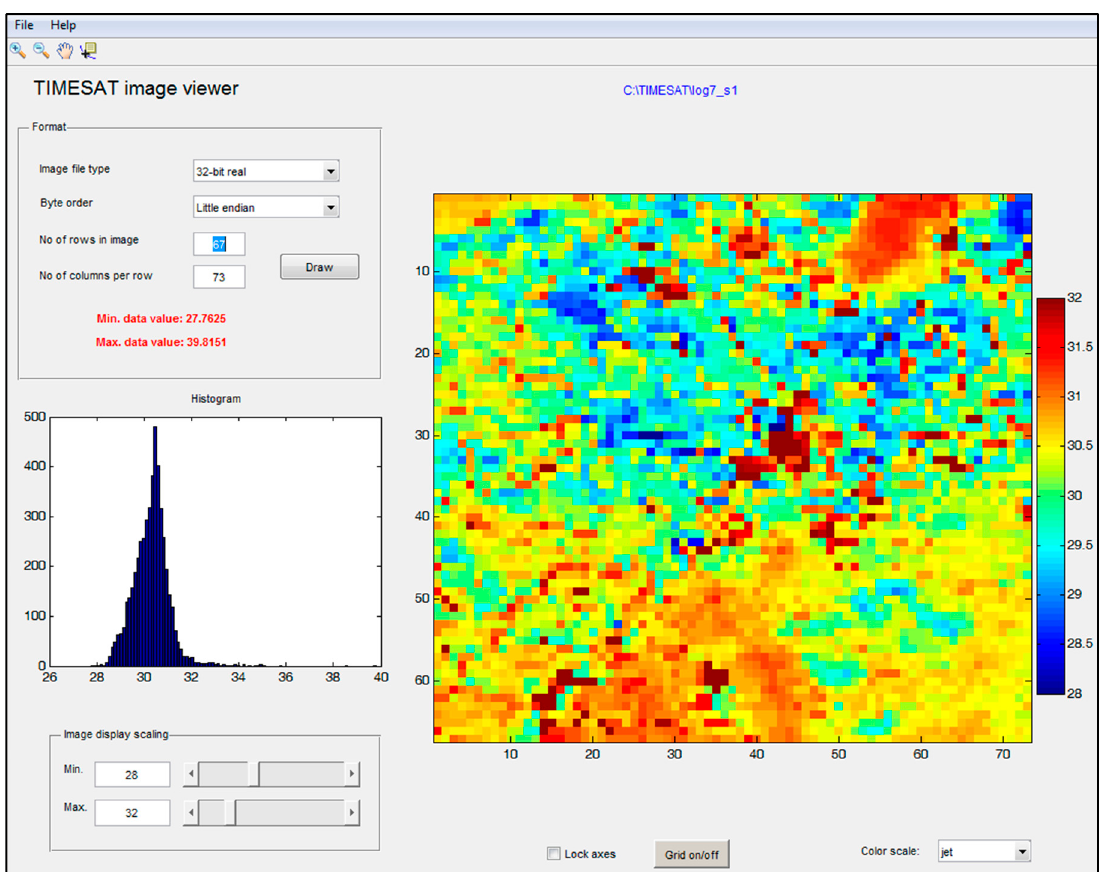
Figure 4. An example of the thematic image produced by the TIMESAT image viewer for start of season within the city for 2007. Colors represent, for each 250-m MODIS pixel, start of season (labeled as discussed in the text), with reds signifying later start of season, as indicated by the legend at the right.